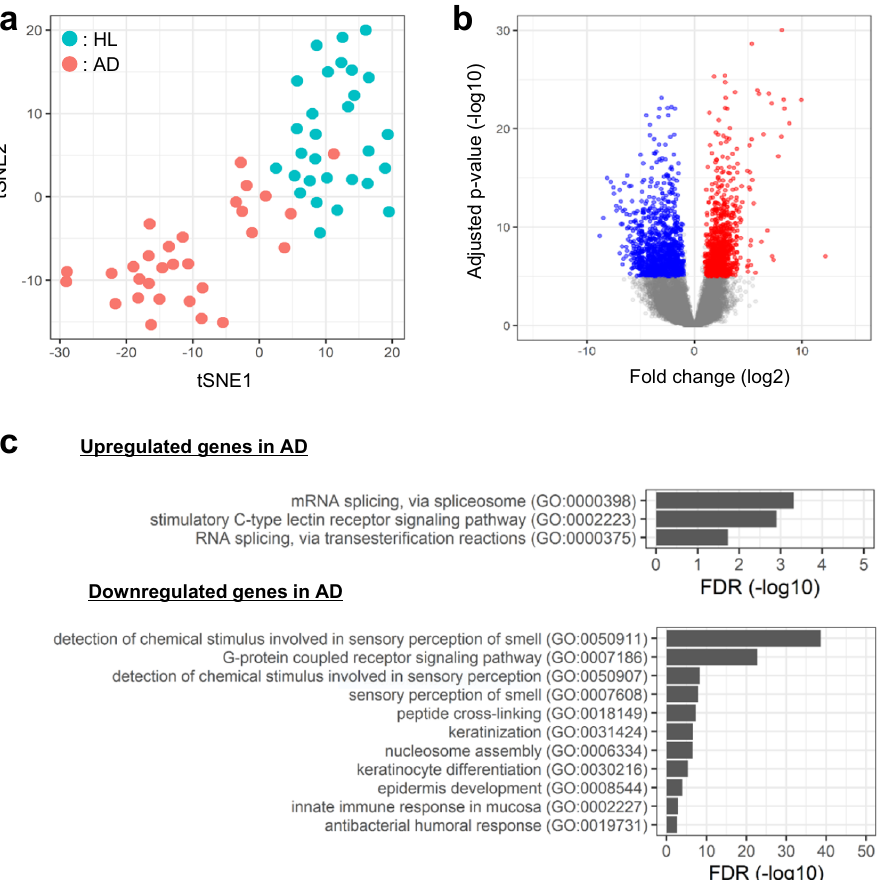
Fig. 6 Characterization of SSL-RNAs pro fi les in healthy subjects (HL) and patients with AD. a t-SNE analysis using variance stabilizing transformation (VST) values for all genes (green, HL; red, AD). b Volcano plot of differentially expressed genes (DEGs) (red, upregulated; blue, downregulated) in patients with AD compared to HL subjects (Benjamini-Hochberg adjusted p value < 10 − 5 and fold change > 2.0). c Gene ontology analysis of DEGs. The upper panel shows signi fi cant biological process (BP) of upregulated DEGs and the lower panel shows BP of downregulated DEGs in patients with AD (FDR < (Fig. 7a). The expression of 25 genes involved in lipid metabolism (GO:0006629) was downregulated in patients with AD compared to healthy individuals (Fig. 7b). Furthermore, genes encoding peroxisome proliferator-activated receptor alpha ( PPARA ), per- oxisome proliferator-activated receptor gamma ( PPARG ), MYC proto-oncogene, bHLH transcription factor ( MYC ), transforming growth factor beta 1 ( TGFB1 ), tumor protein p53 ( TP53 ), and PR/SET domain 1 ( BLIMP1 ) regulate sebocyte differentiation and sebum production in vivo and ex vivo 47 – 50 . Among these gene, the expression of TGFB1 was signi fi cantly upregulated in patients with AD than in healthy subjects (Fig. 7c).